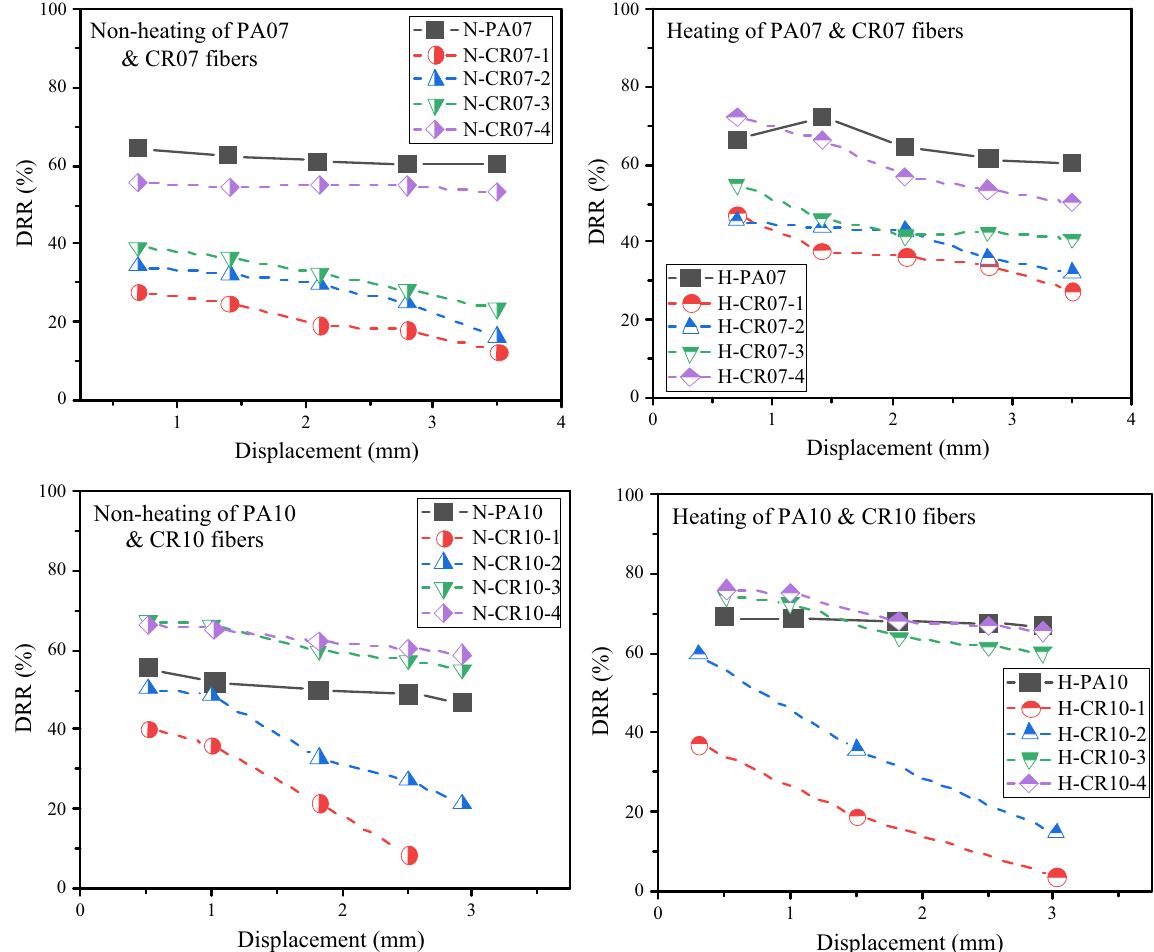
Figure 9: DRRs of paddled and crimped fi bers with and without